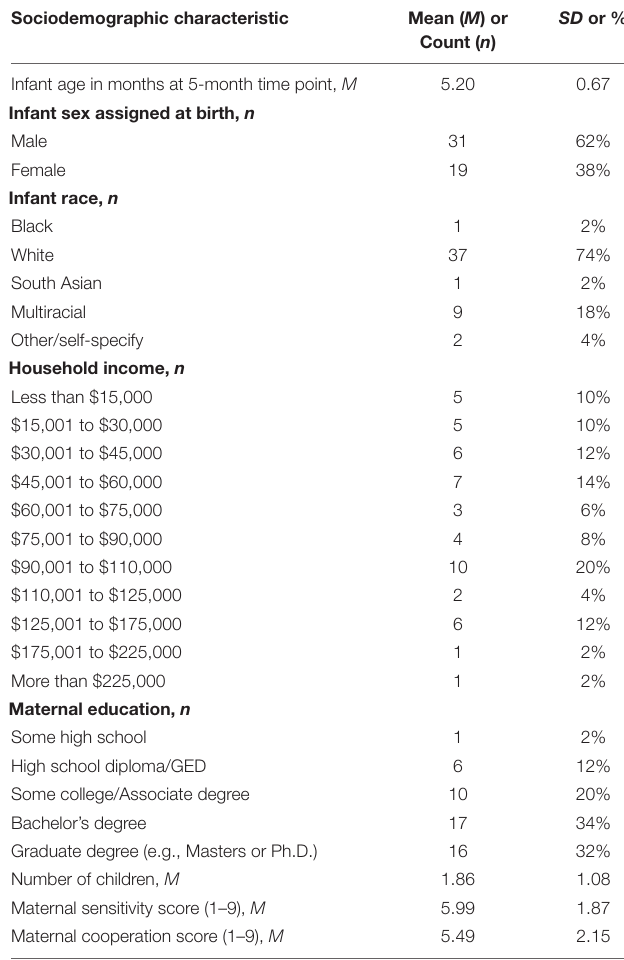
TABLE 1 | Sociodemographic characteristics of included